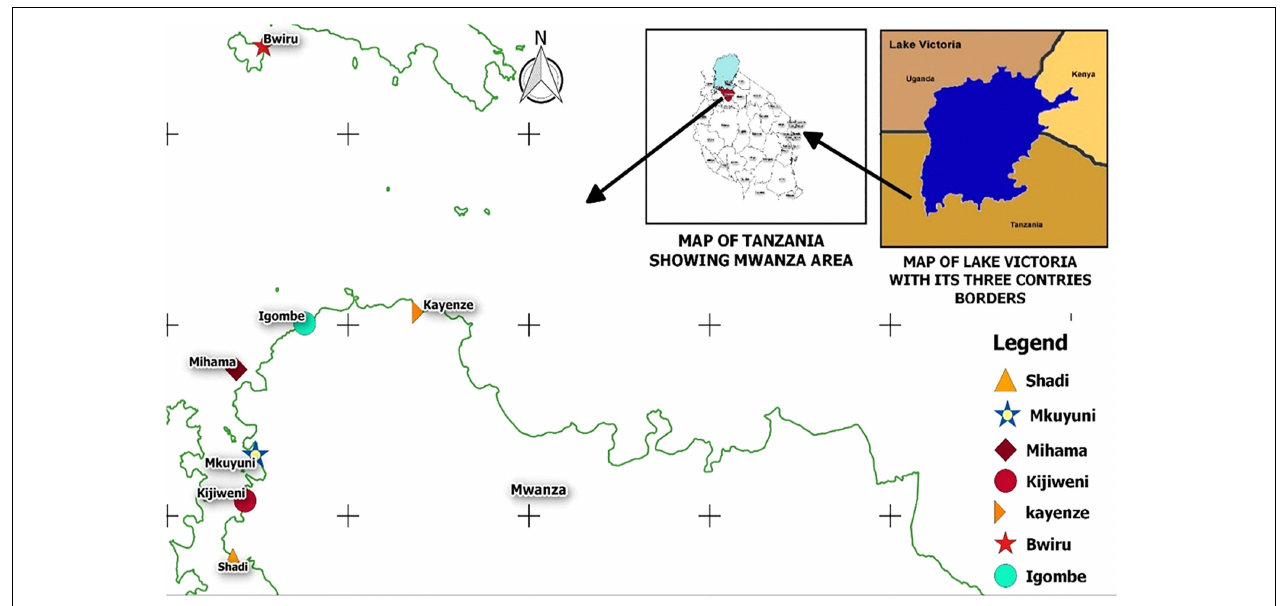
FIGURE 1 | Sampling points in Lake Victoria, Mwanza, Tanzania.